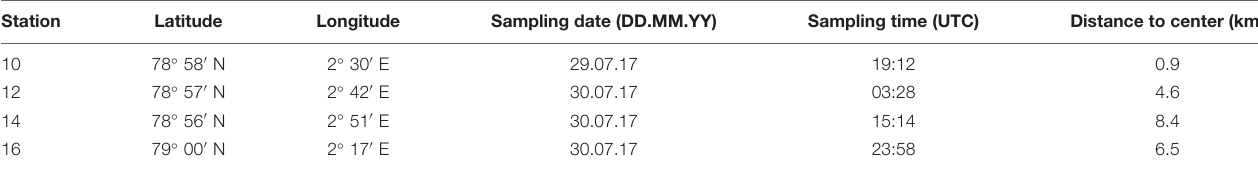
TABLE 1 | Geographic position, sampling date and time as well as the distance to the center of the filament of the four MultiNet Stations sampled across a submesoscale filament in Fram Strait. Station